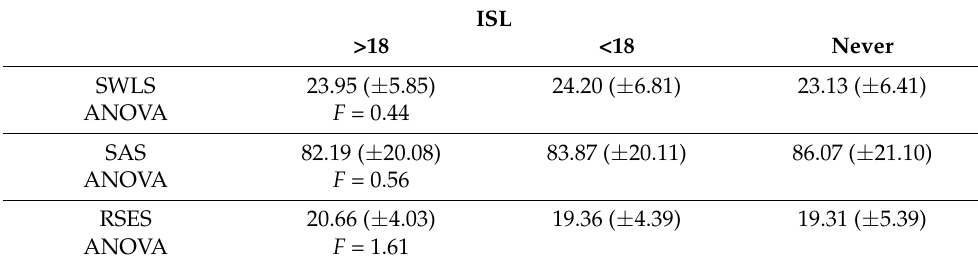
Table 3. Mean score s(SD) and F statistics of ANOVA between groups.